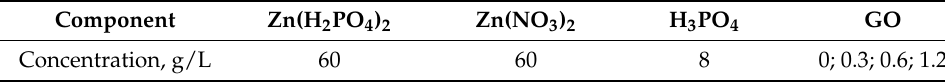
Table 3. Chemical composition of phosphating